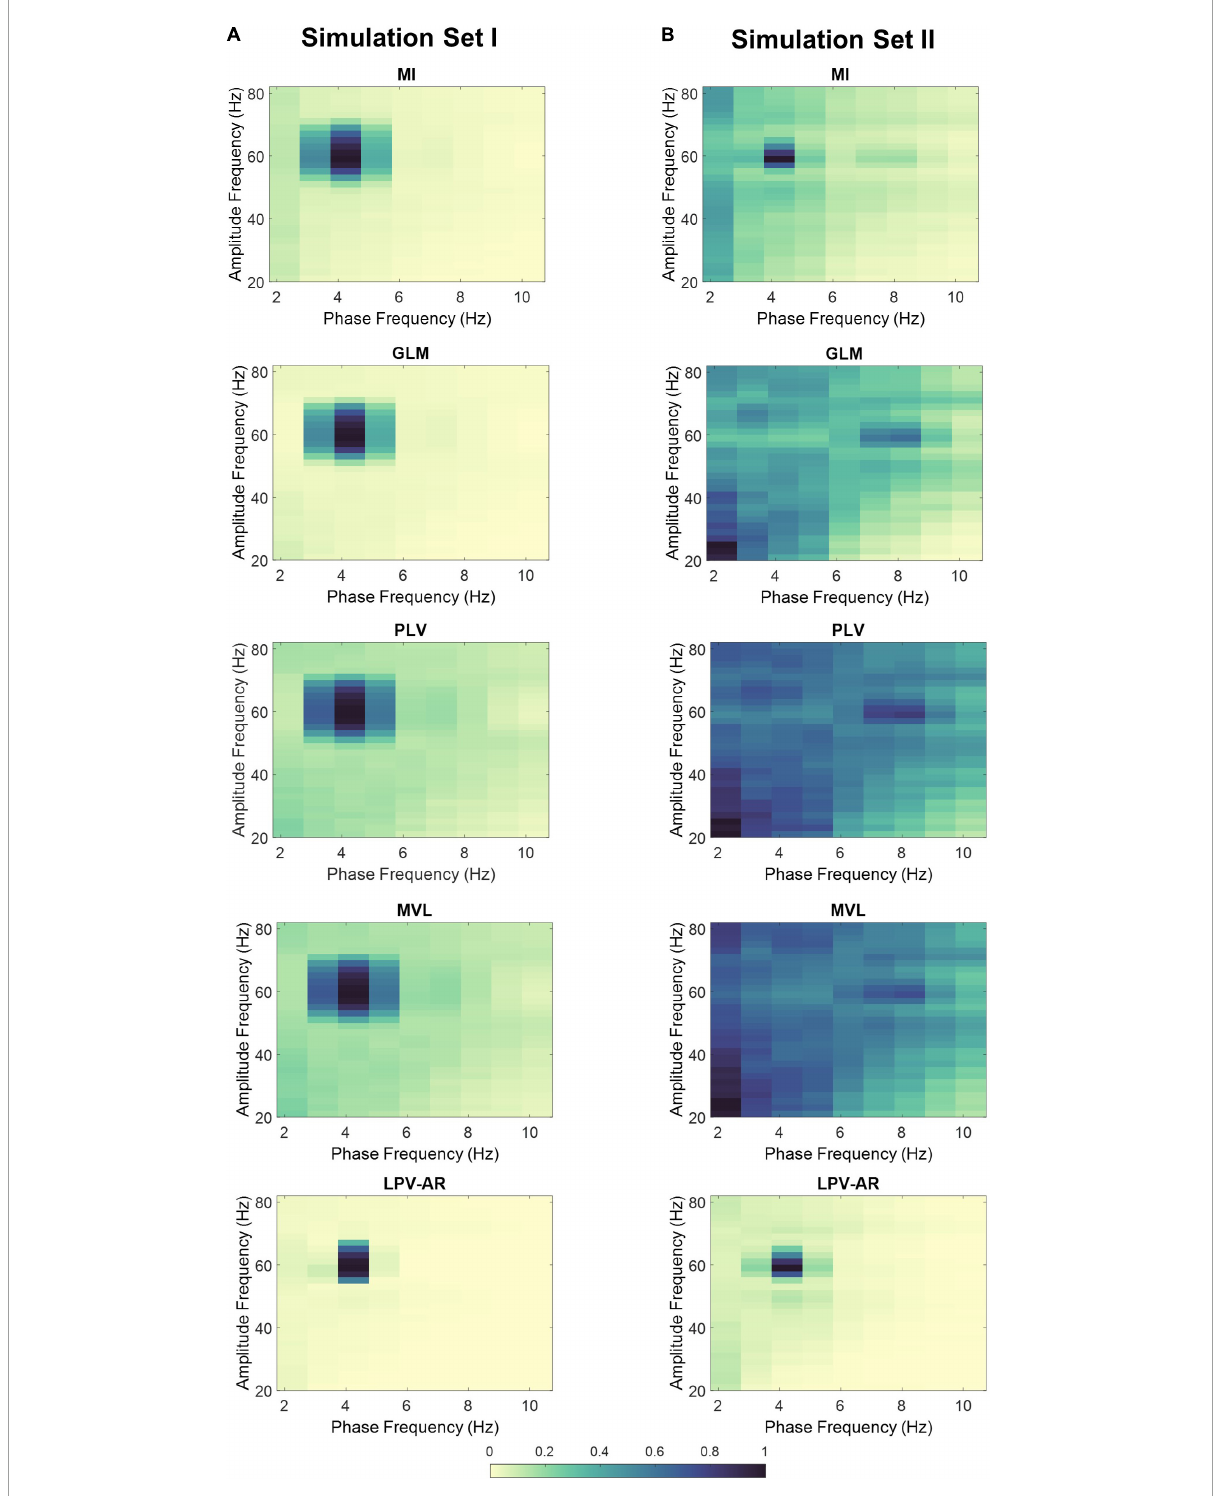
FIGURE4 Average comodulograms over 100 realizations for (A) simulation set I and (B) simulation set II. Each row corresponds to a different method (i.e., MI first row, GLM second row, PLV third row, MVL fourth row, and LPV-AR fifth row). For comparison purposes, the average comodulogram of each method was normalized by its maximum value over all phase and amplitude